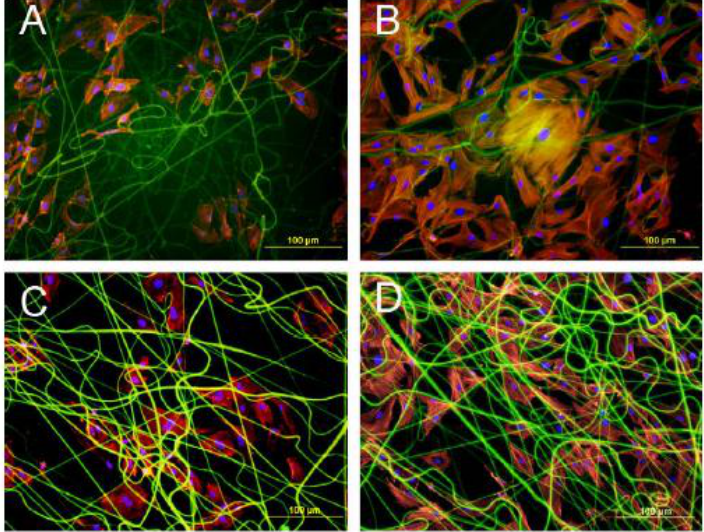
Figure 4. Fluorescence microscopy images of DAPI and rhodamine phalloidin staining of (A and B) HUVECS and (C and D) HCASMCs on HMDI cross-linked synthetic elastin microfibers (A and C) and glutaraldehyde cross-linked microfibers (B and D) after 24 hours. Reprinted from [79], Copyright 2010, with permission from